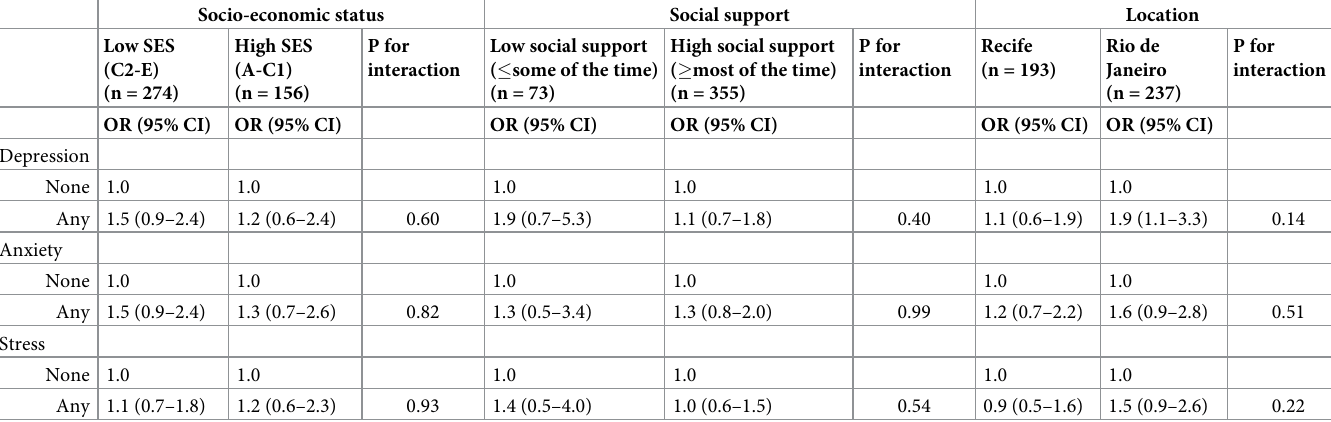
Table 5. The association of depression, anxiety and stress with parenting a child with CZS, stratified by SES, social support and location. Socio-economic